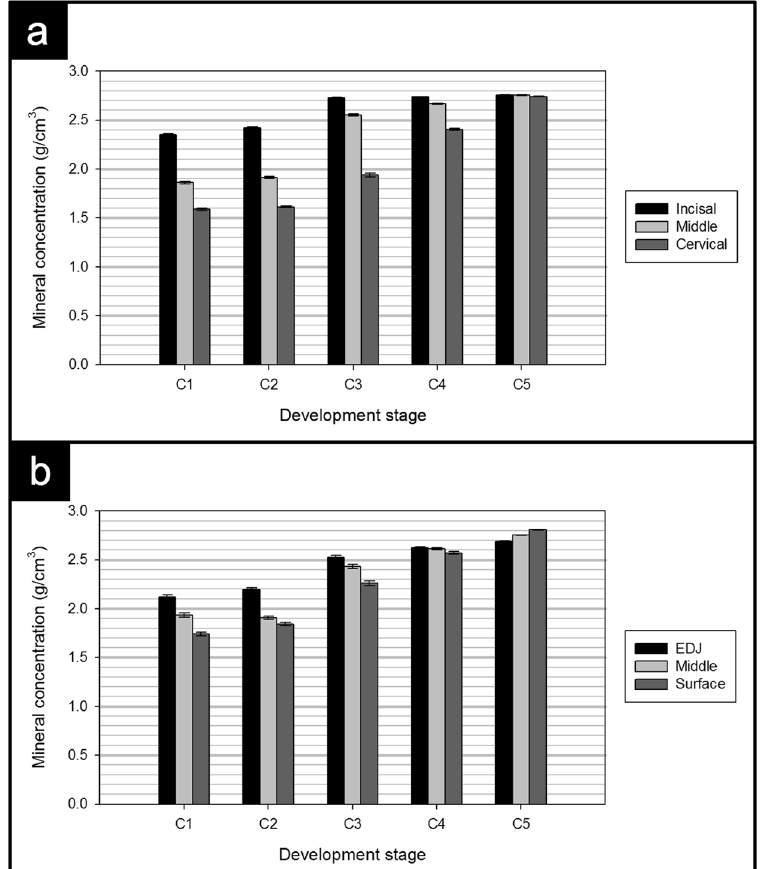
Figure 2. ( a ) Vertical and ( b ) horizontal distribution of mineral concentration of central incisal enamel at various developmental